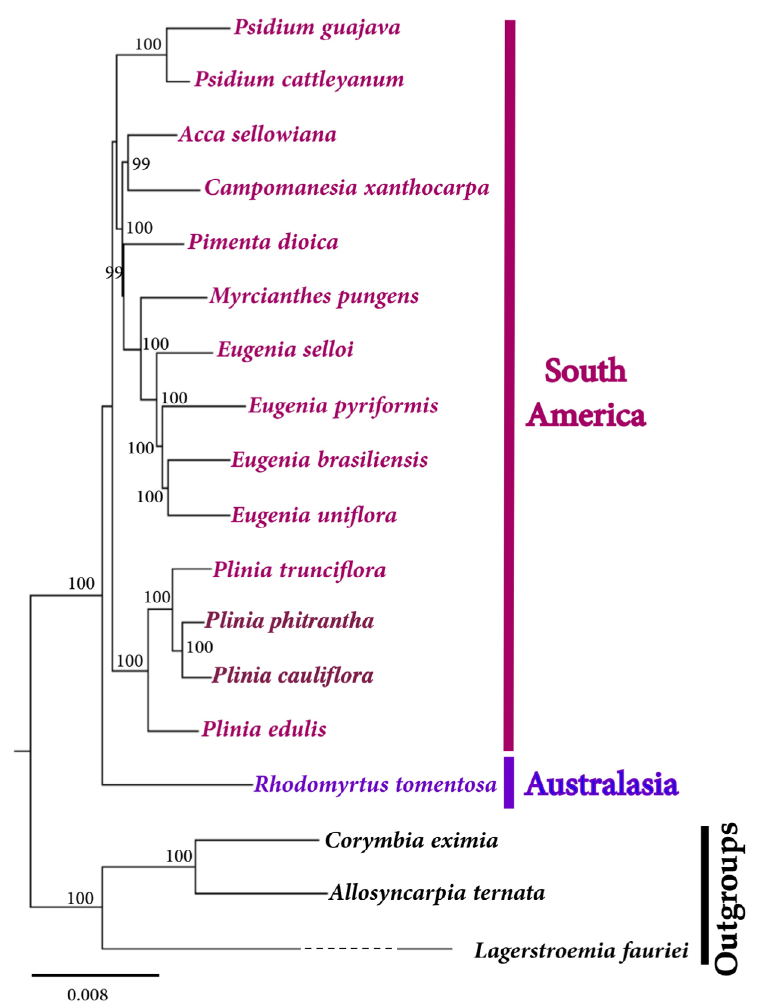
Figure 3 – Maximum likelihood phylogenomic relationship among species of tribe Myrteae based on whole plastid genome sequences. C. eximia, A. ternata, and L. fauriei were used as outgroups. Numbers at the nodes are bootstrap support after 1000 permutations. The branch length of L. fauriei was shortened in the figure (dashed